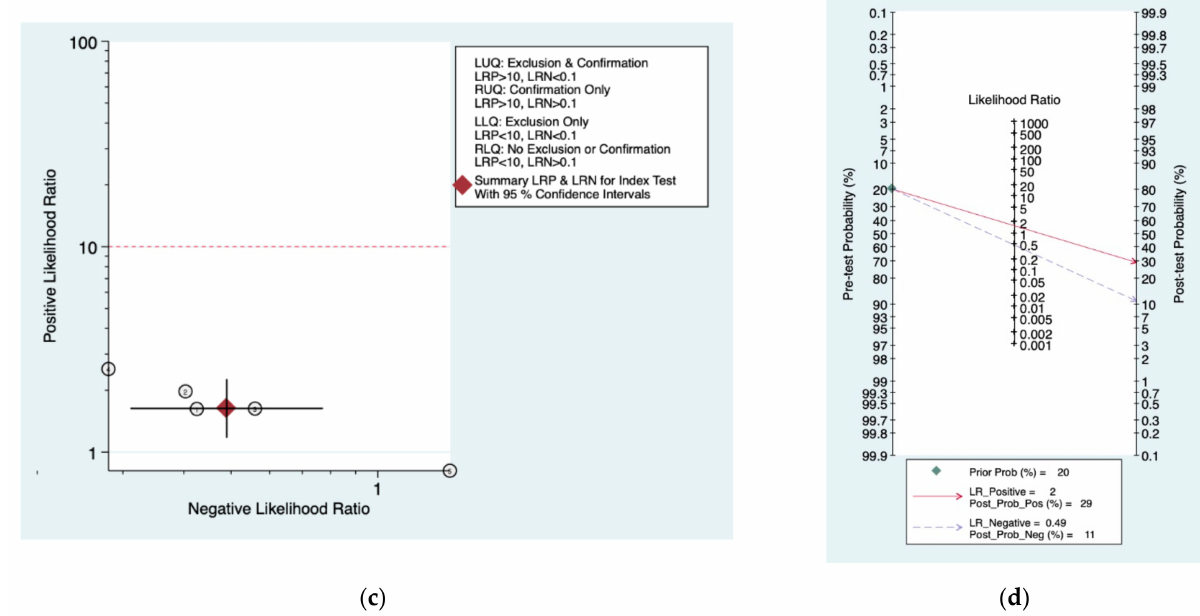
Figure 5. Meta‑analysis of Schlauch and Levine protocol. ( a ) Forrest plot of pooled sensitivity and specificity [8,21,23–25]; ( b ) Hierarchical summary receiver operating characteristic (HSROC) curve; ( c ) Likelihood ratio scattergram; ( d ) Fagan nomogram.